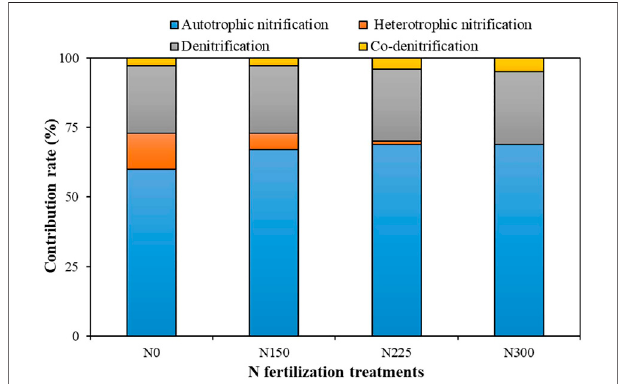
FIGURE 3 | The contribution of each microbial process to N 2 O emissions. N0: 0 kg N hm − 2 a − 1 ; N150: 150 kg N hm − 2 a − 1 ;